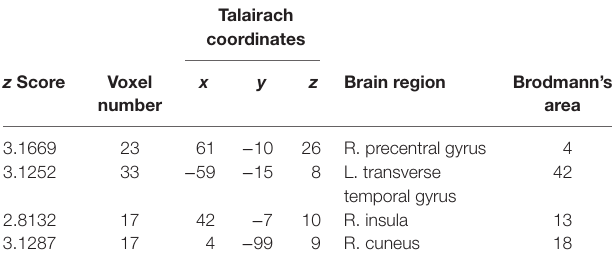
TaBle 8 | Areas of decreased activation for traumatic slides and sounds in mindfulness-based stress reduction greater than present-centered group